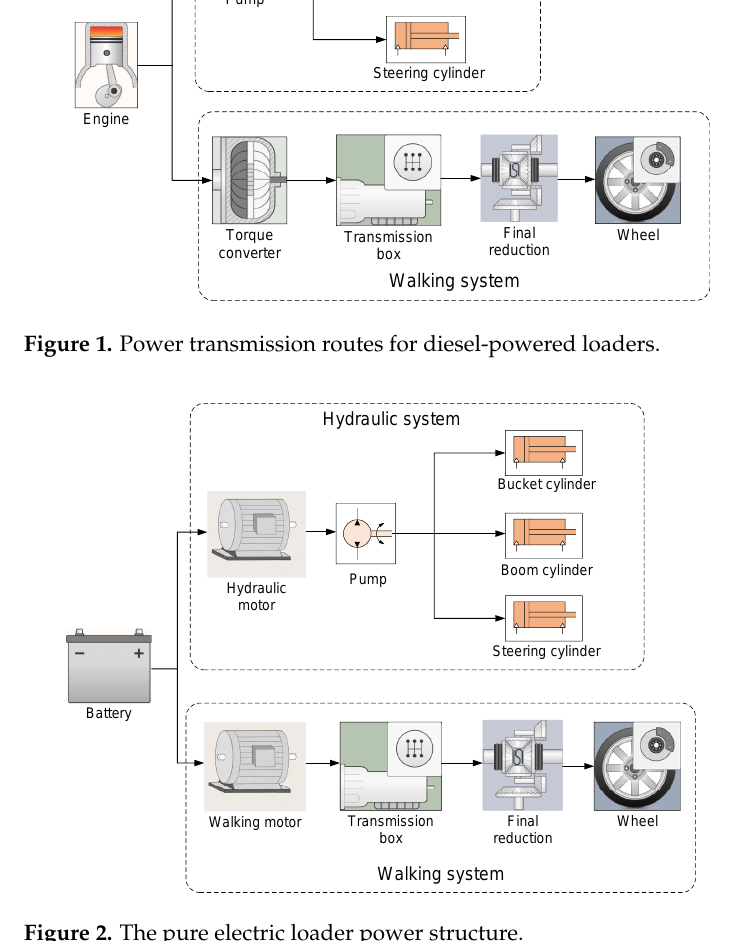
Figure 2. The pure electric loader power